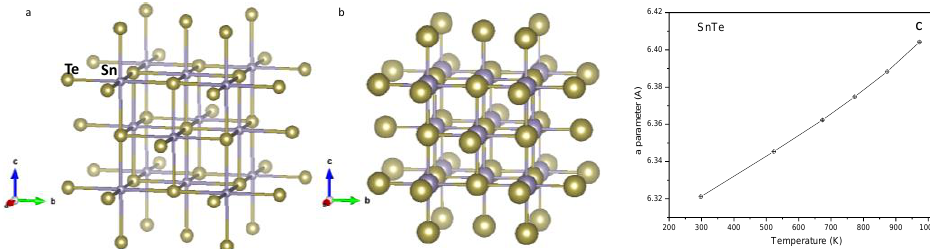
Figure 3. Views of the cubic crystal structure, highlighting the evolution of the displacement parameters with temperature, from NPD data, at ( a ) 298 K and ( b ) 973 K. ( c ) Thermal variation of the a unit-cell parameter.